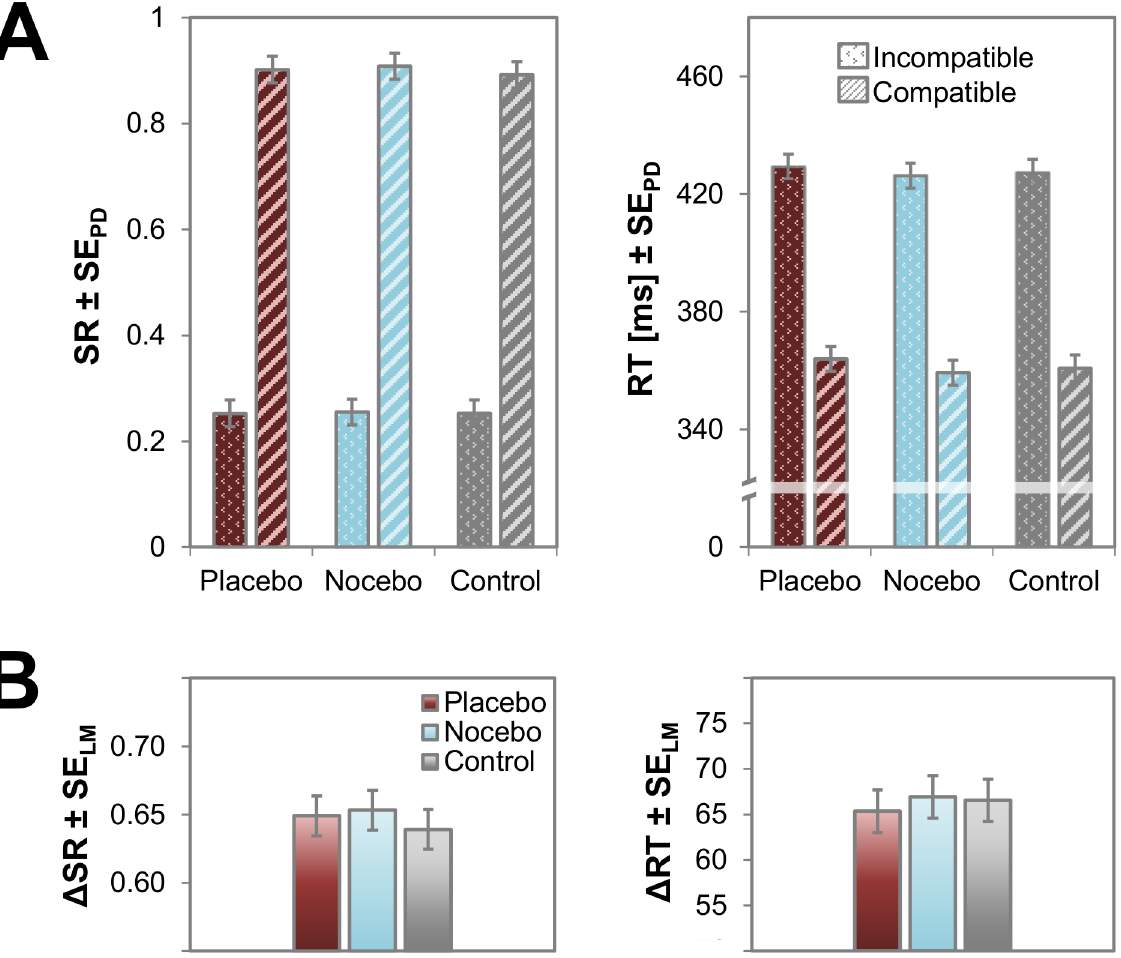
Fig 2. A. Success rates (SRs) and reaction times (RTs) as a function of expectancy and Flanker compatibility. Error bars indicate standard errors of paired differences [39], computed separately for each expectancy condition. B. Compatibility effects for each expectancy condition, computed as Δ RT = RT Δ SR = SR compatible -SR incompatible and incompatible -RT compatible . Error bars indicate the Loftus-Masson within-subjects standard error for repeated measures ANOVA [40]. Flanker compatibility effects emerged for SRs and RTs, but these effects did not significantly differ between the three expectancy conditions and no main effect of expectancy was